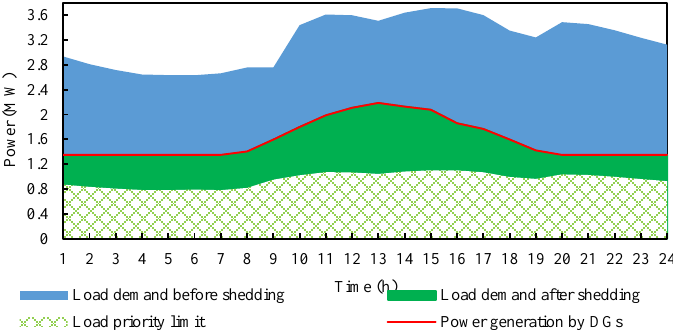
Figure 8. Load demand before/after applying the proposed load-shedding technique by hybrid FAPSO.